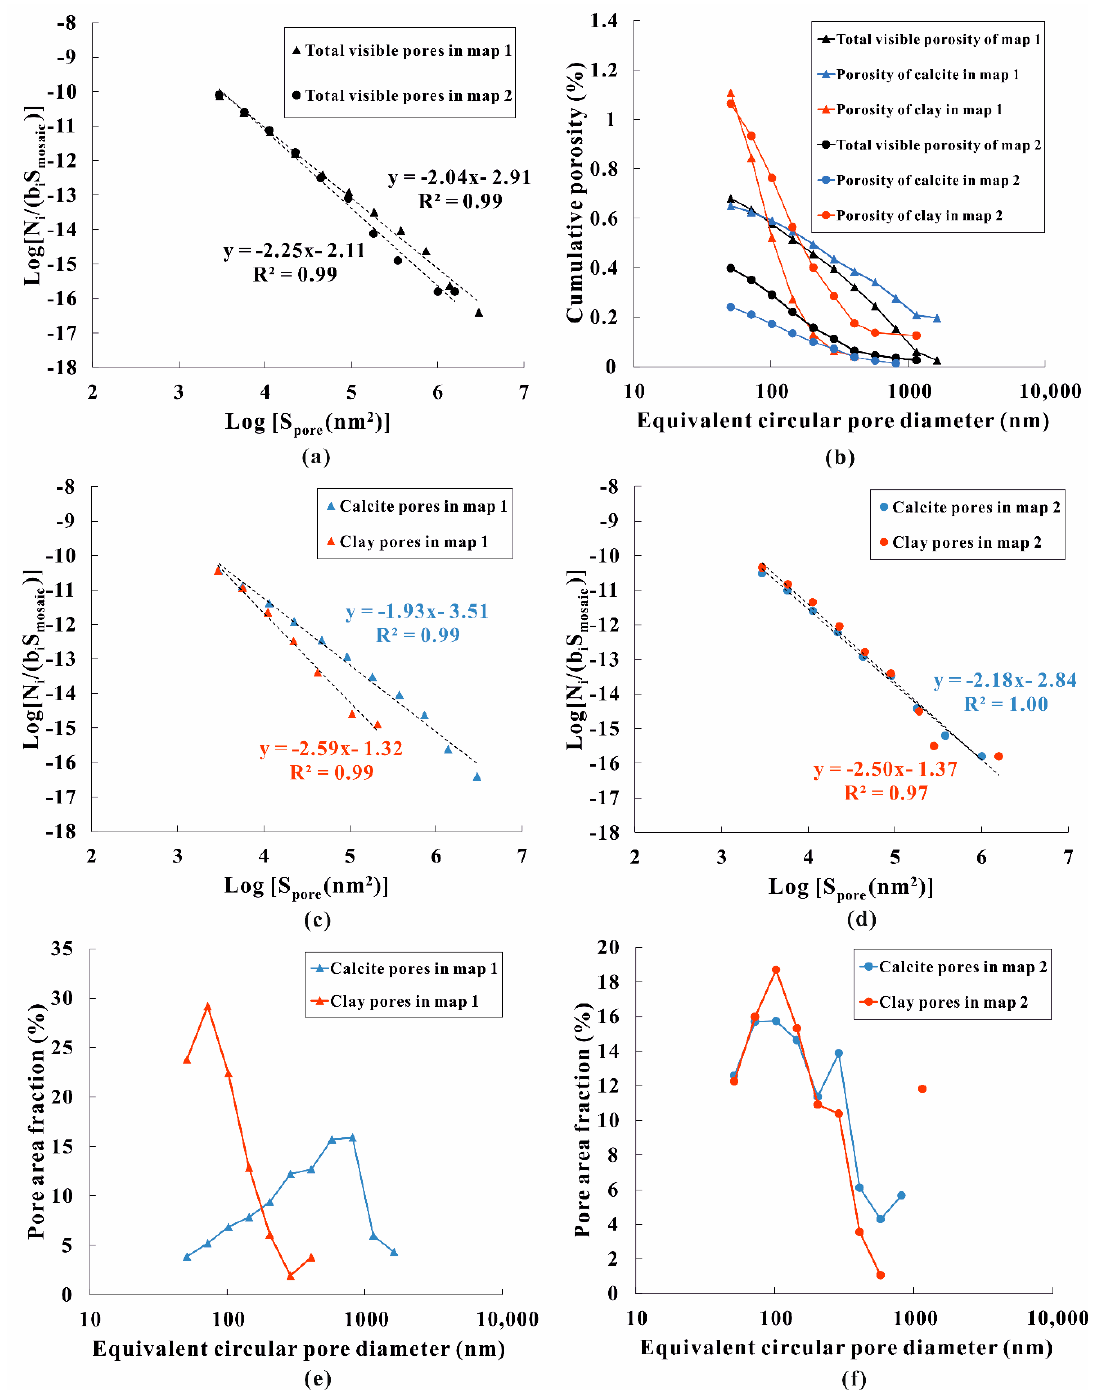
Figure 9. Normalized pore size distributions of total visible pores in maps 1 and 2 ( a ). The linear best fit is shown as a dashed line with a corresponding equation. The slope and intercept of the best fit are the minus D and log C values of Equation (2), respectively. Cumulative porosity distributions of total visible pores in maps 1 and 2 and corresponding cumulative porosity distribution of clay and calcite phases (pore area normalized to respective mineral phase area) ( b ). Normalized pore size distributions in calcite and clay mineral phases of map 1 ( c ) and map 2 ( d ). Pore area fraction distributions of calcite and clay mineral phases in map 1 ( e ) and map 2 ( f ).